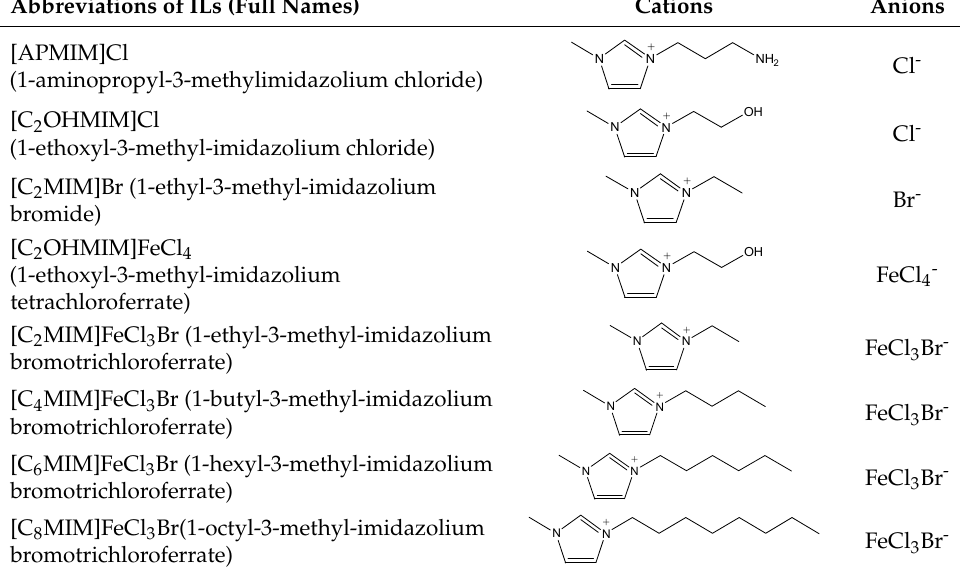
Table 3. The full names and chemical structures of the ILs used in this study. Abbreviations of ILs (Full Names)